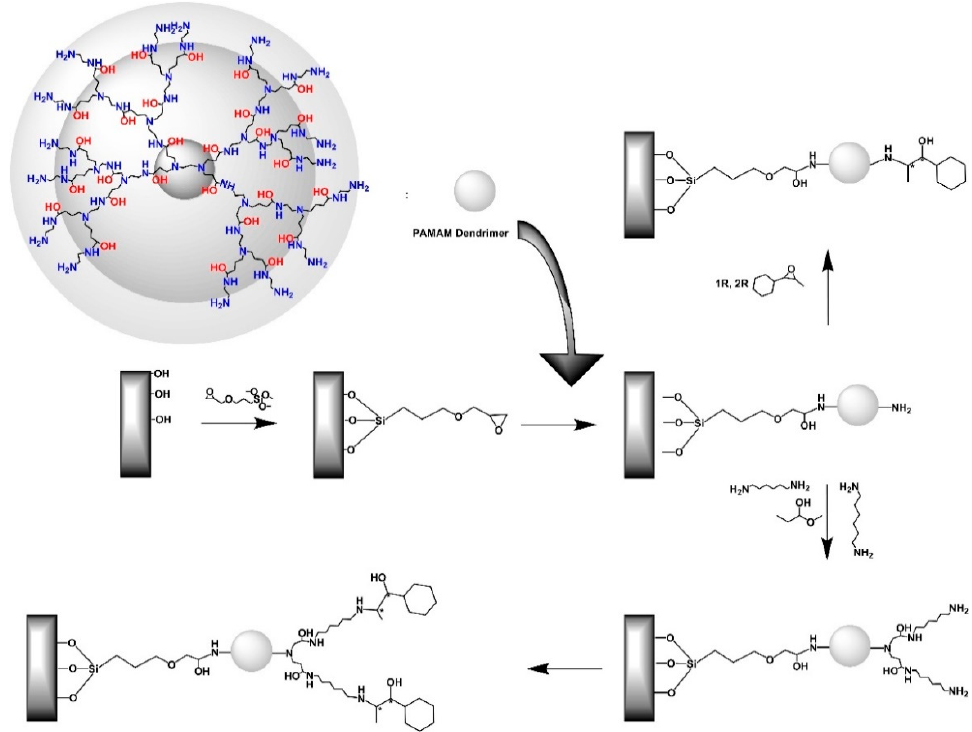
Figure 10. Synthetic path for the immobilization of PAMAM dendrimers decorated by chiral functionality onto silica substrate. (Reproduced with permission from [87]; Copyright Elsevier, 2003).